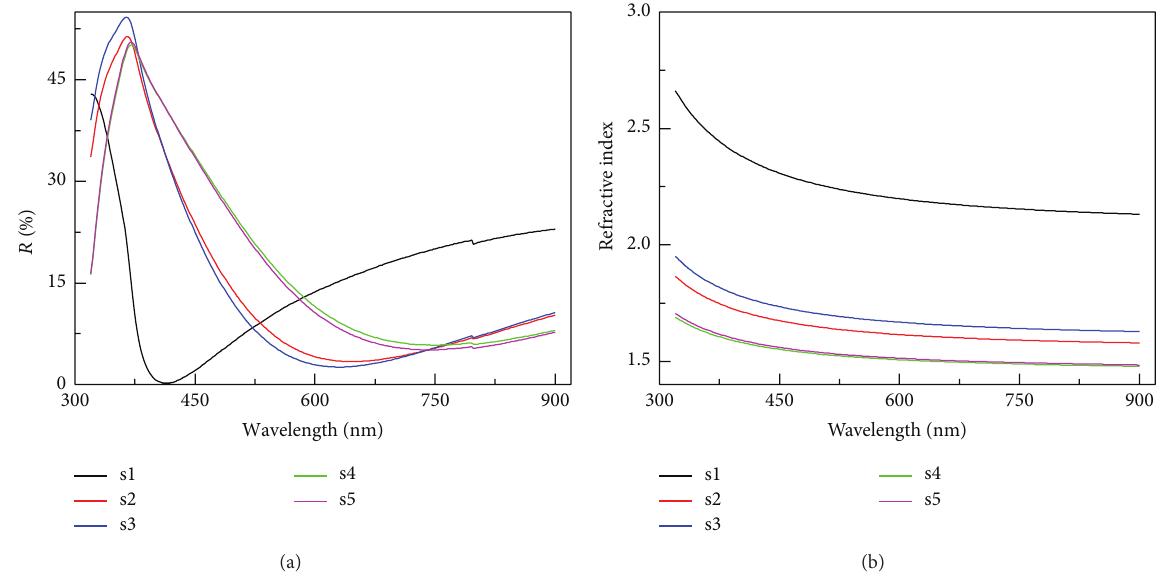
Figure 2: Reflectance spectra (a) and refractive index dispersion curves (b) of the studied Nb 2 O 5 films.